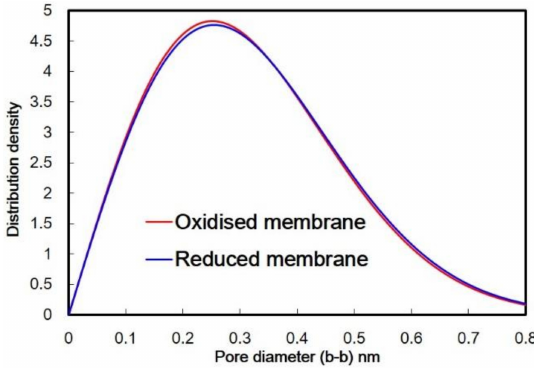
Figure 10. Calculated pore size distribution of silica membrane in oxidized state and reduced